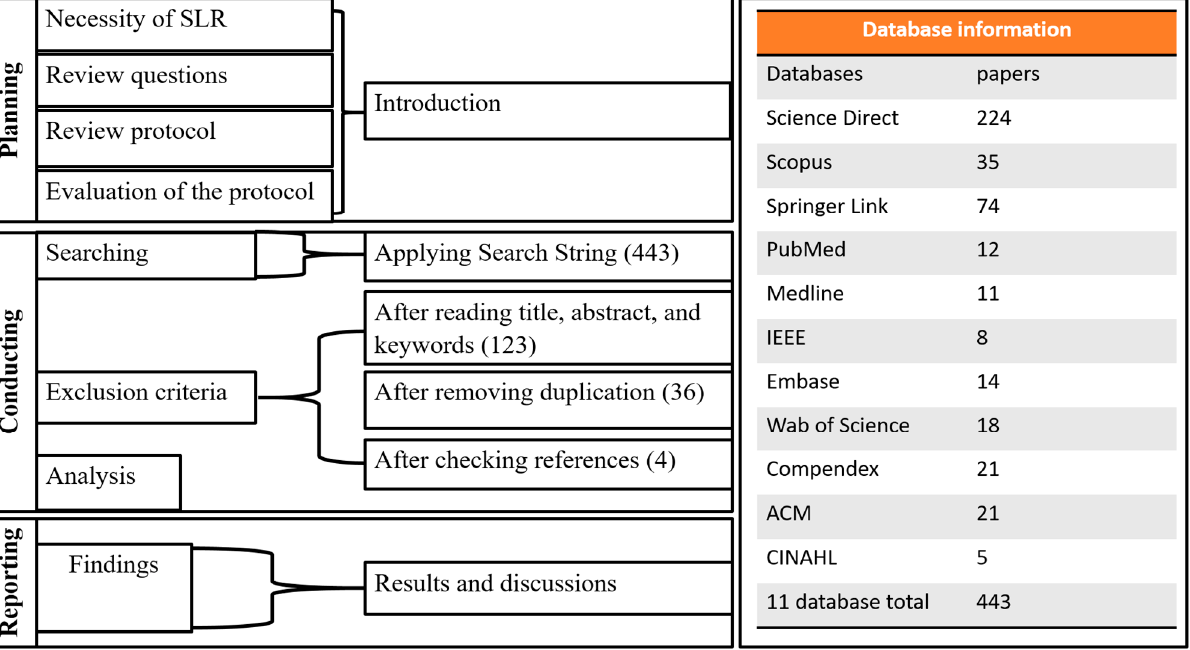
Figure 2. Overview of proposed SLR .